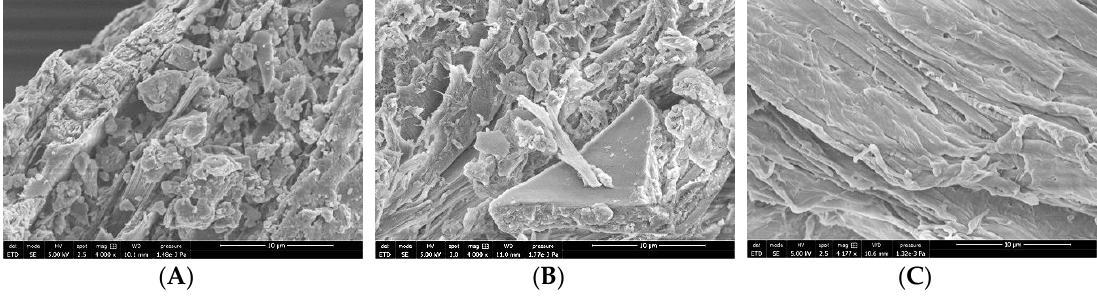
Figure 5. SEM images of ( A ) raw material, ( B ) demineralized, and ( C ) decolorized samples.